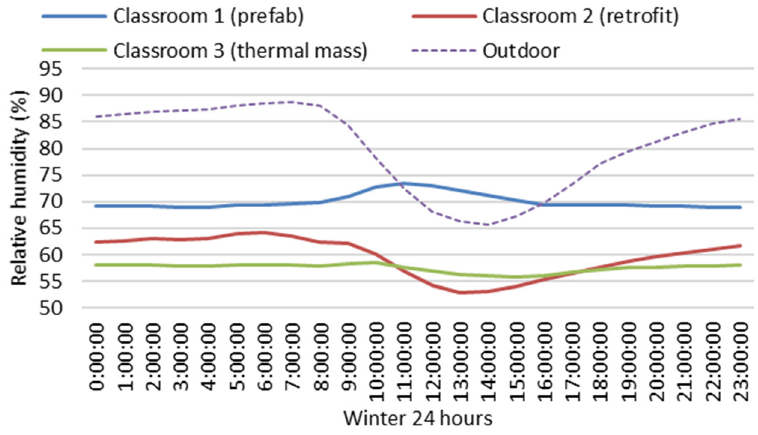
Figure 11. Winter outdoor and indoor hourly mean relative humidity of the three classrooms.